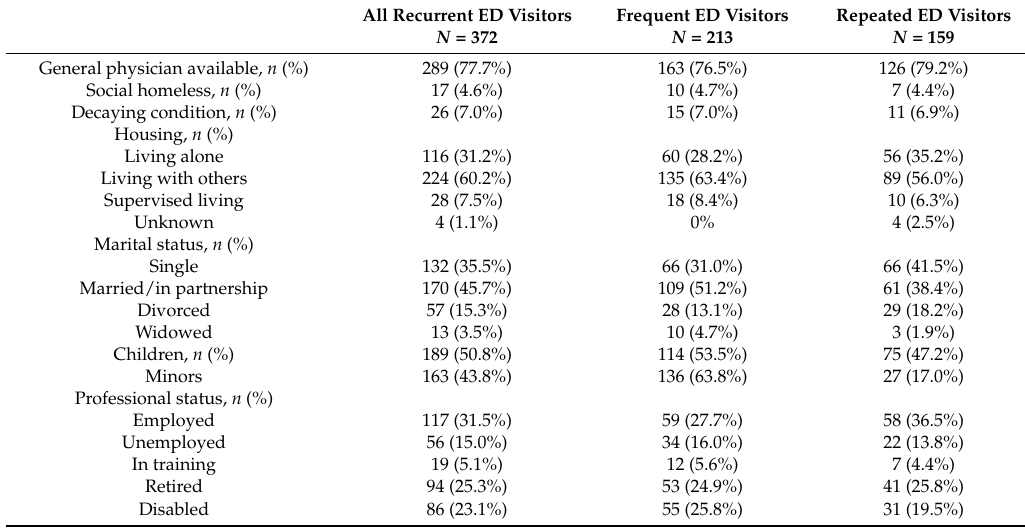
Table 2. Social state of recurrent ED visitors.